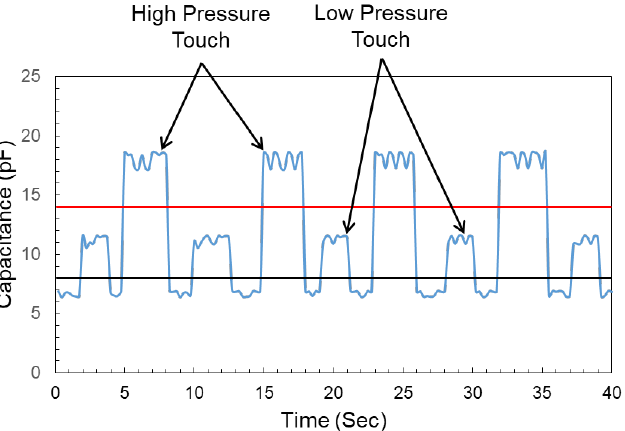
Figure 3. Single sensor response to no touch, low-force touch, and high-force touch conditions.